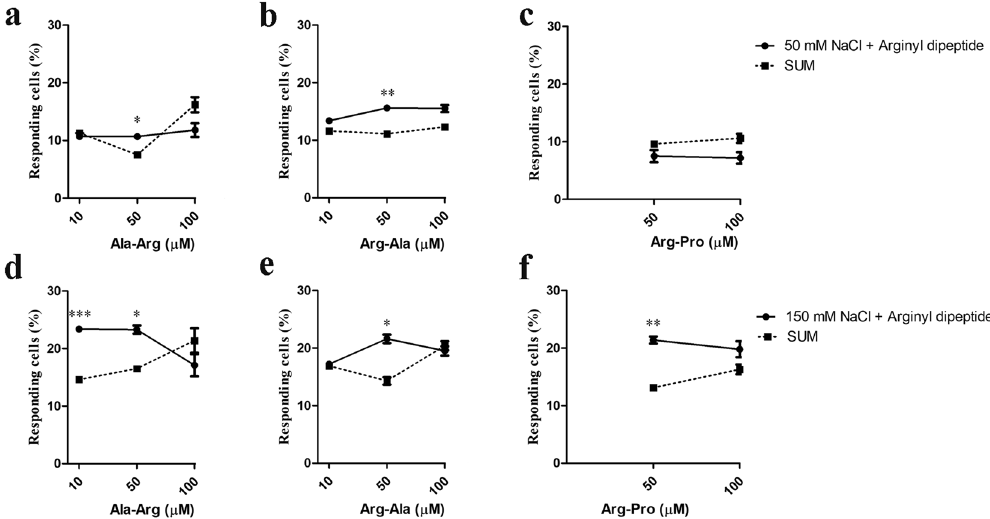
Figure 2. Effects of Ala-Arg (AR), Arg-Ala (RA), and Arg-Pro (RP) on NaCl-elicited responses. HBO cells were consecutively stimulated by dipeptide alone, NaCl alone (50 mM, ( a–c ); 150 mM, ( d–f )), and a mixture of dipeptide and NaCl. SUM is the mathematical addition of individual responses (NaCl alone + dipeptide alone). The percentage of responding cells was determined by measuring intracellular Ca 2 + changes. Each experiment was performed at least nine times. * p < 0.05, ** p < 0.01, *** p < 0.001, comparing the mixture (dipeptide and NaCl) and SUM. For each panel the peak number of responding cells/total cells examined were: 91/1990 ( a ), 84/1706 ( b ), 20/394 ( c ), 174/1640 ( d ) 188/1931 ( e ), and 110/1143 ( f